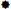
Sampling sites of Lampetra populations in Europe.Species: ■, L. fluviatilis; ●, L. planeri; ○, L. alavariensis; ★, L. lusitanica; , L. auremensis. See Table 1 for details about species and sampling sites.